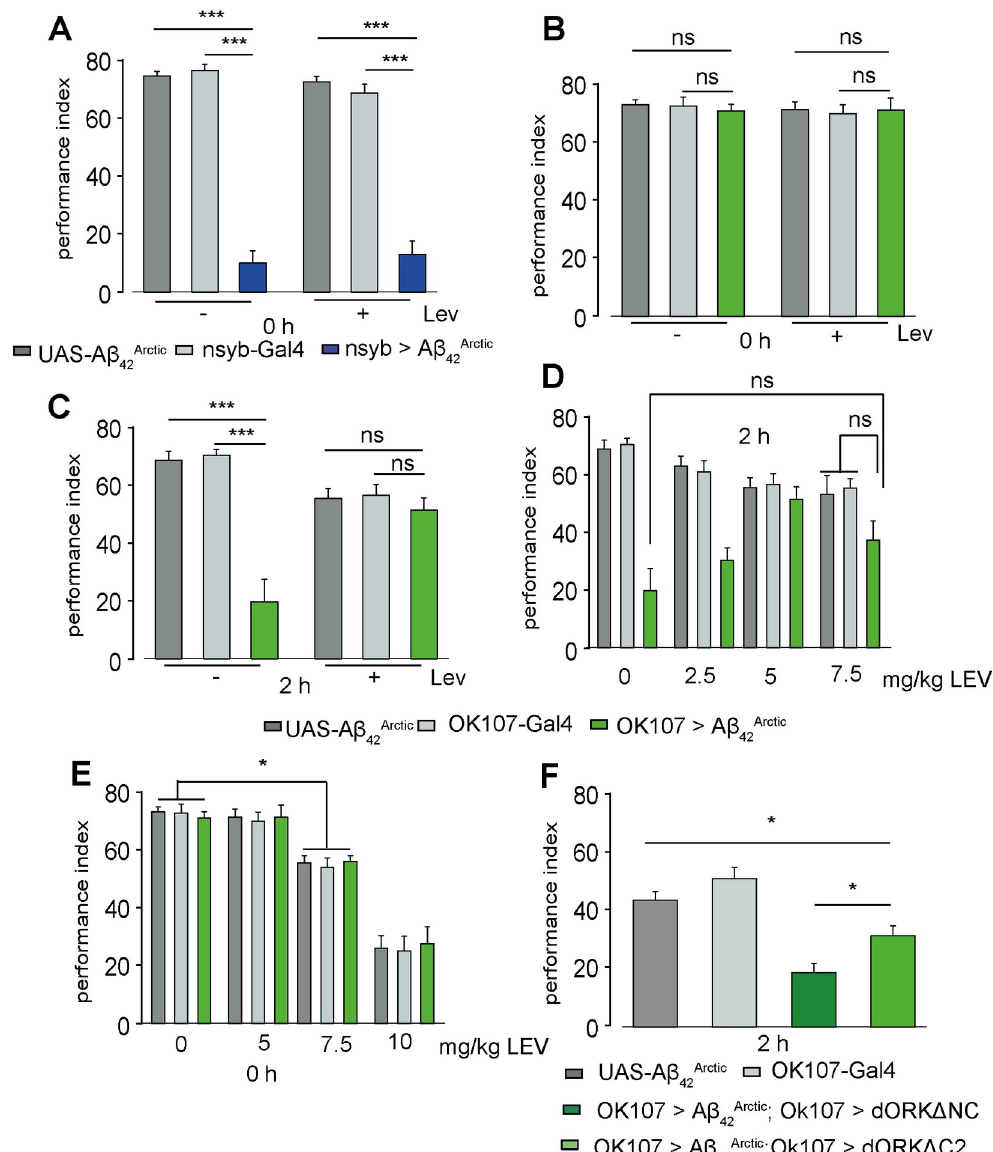
Fig 2. Reducing neuronal excitability with LEV or dORK Δ C rescues memory defects caused by the expression of A β 42Arctic . (A) Pan-neuronal expression of A β 42Arctic reduced aversive 0-h memory, which could not be restored with LEV treatment (n � 12). (B) LEV treatment does not affect flies expressing A β 42Arctic in the MB directly after training (n � 12) but (C) restored the impaired 2-h memory performance in flies expressing A β 42Arctic in the MB (n � 12). (D) Flies were fed with either 2.5 or 7.5 mg/kg LEV, and 2-h aversive memory was tested. The data for 5 mg/kg are from Fig 3C (n � 12). Other LEV concentrations do not seem to improve the memory performance. (E) Flies were fed with either 7.5 or 10 mg/kg LEV, and 0-h aversive memory was tested. The data for 5 mg/kg are from Fig 3B (n � 12). Higher LEV concentrations seem to have a negative effect on the flies’ ability to learn (F) Expression of the nonconducting K + -channel dORK Δ NC or constitutive conducting dORK Δ C in the MB of A β 42Arctic -expressing flies. At 2 h after training, dORK Δ C is able to partially restore the learning performance compared to dORK Δ C (n � 12). See S4 Fig for the further data on LEV and dORK and S1 Table for the data. All other details are similar to Fig 1. LEV, Levetiracetam; MB, mushroom